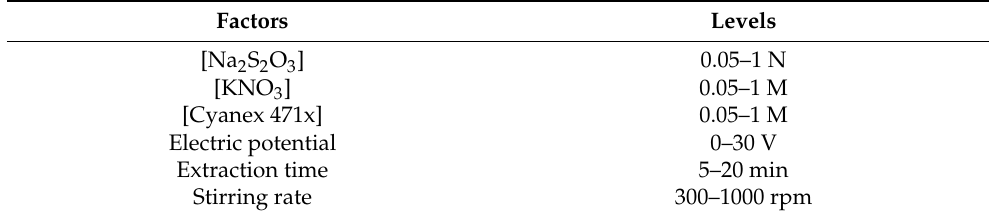
Table 2. Levels of the factors for the fractional factorial